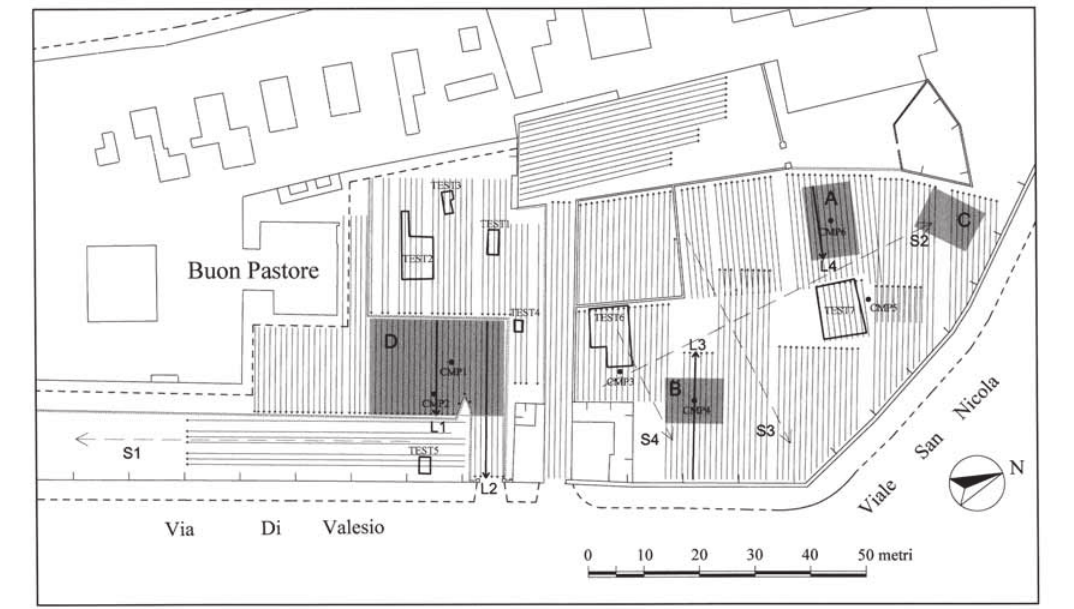
Fig. 2. Location map of the geophysical surveys: seismic refraction (dashed lines S1,..., S4) and GPR (continuous lines); heavy lines refer to profiles whose sections are shown in the next figures. A, B and C denote zones of detailed 3D GPR surveys. The dots mark the centres of the CMP gathers carried out for velocity estimation. Tests 1 to 7 denote archaeological